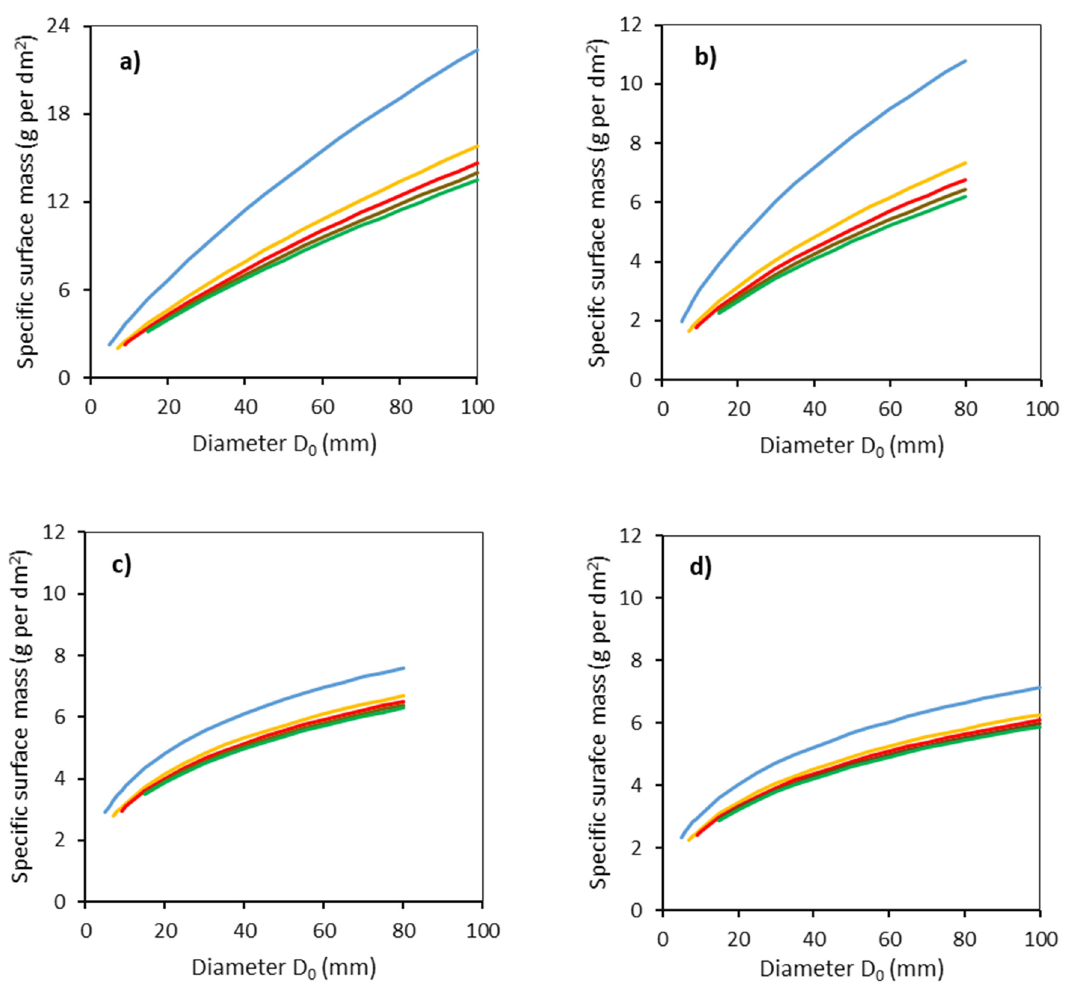
Figure 6. Modeled relationships between specific surface bark mass and stem base diameter D 0 for common aspen ( a ), goat willow ( b ), rowan ( c ) and sycamore ( d ), in individual stem sections defined by the vertical distances from the ground level (blue: 0–50 cm, orange: 51–100 cm, red: 101–150 cm, brown: 151–200 cm, green: 201–250 cm) using Equation (8) and modeled stem radii (Equation (5) and Table 3).